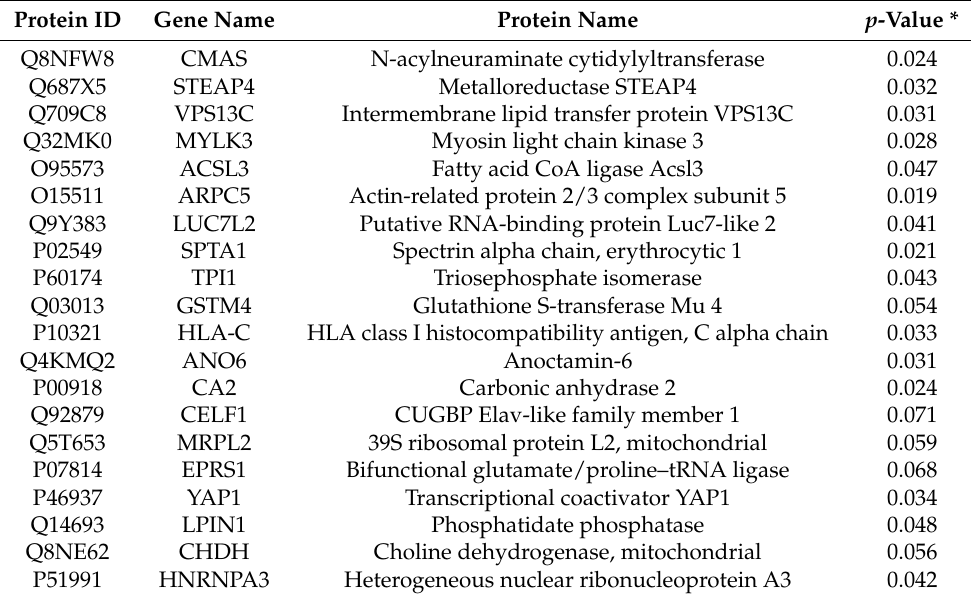
Table 3. Top 20 of proteins with positive association to aortic